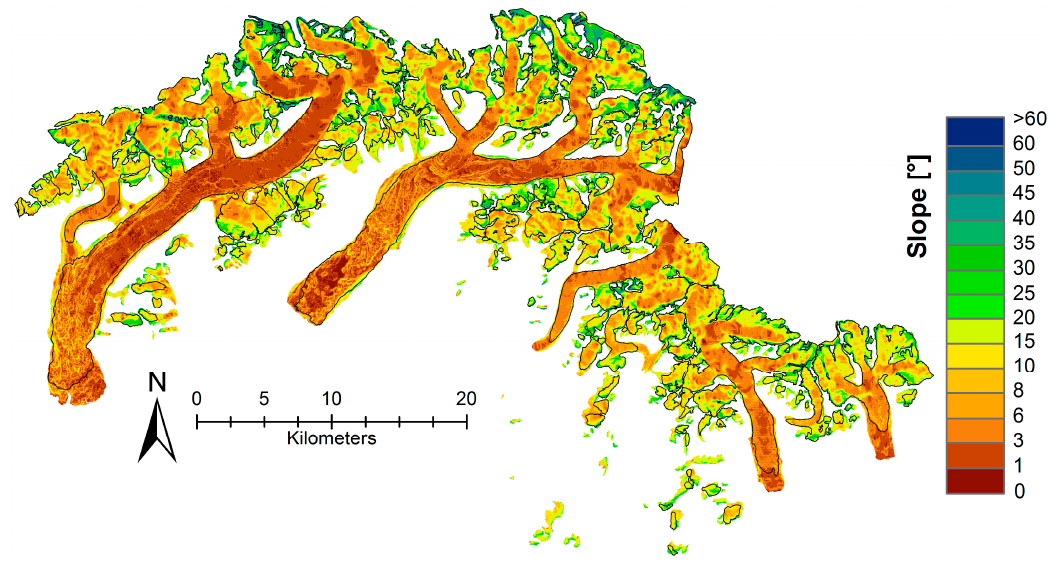
Figure 5. Slope map of the studied glaciers in the Susitna River basin. Slope values [°] were calculated using ArcGIS based on the IfSAR DEM. Glacier outlines of 2010 are shown in black.